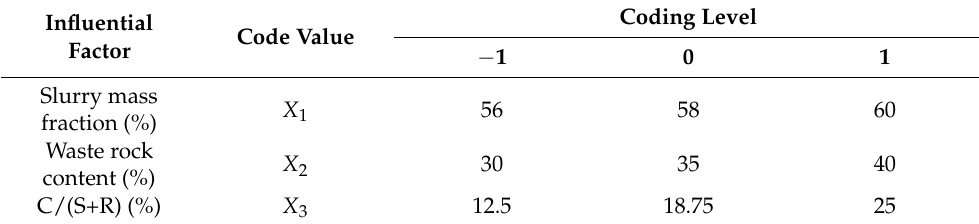
Table 3. Influential factors and level codes of backfill